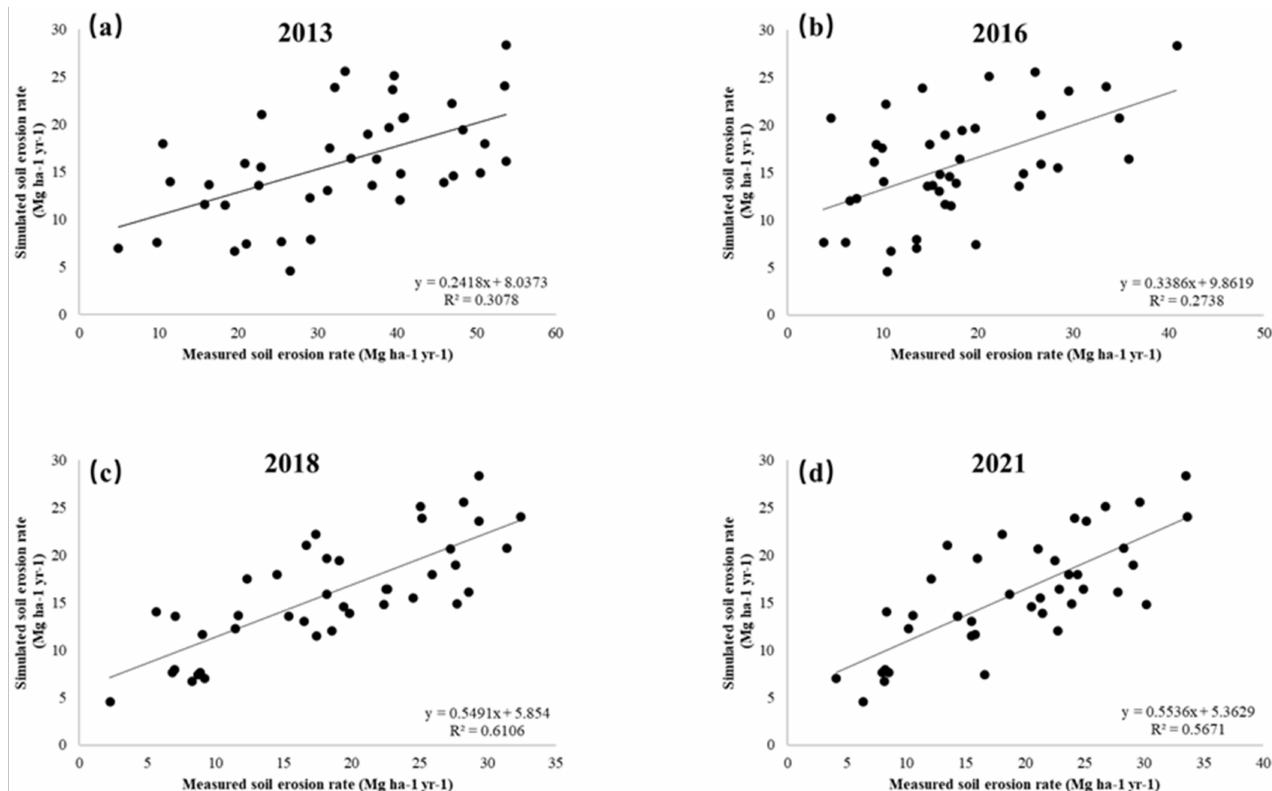
Figure 3. Validation of ( a – d ) the RUSLE model: 2013, 2016, 2018,